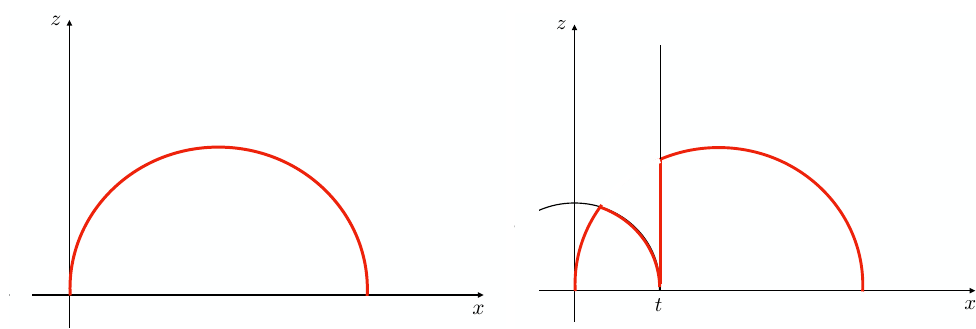
Figure 23 . A schematic drawing of connected geodesic (shaded red) on a time slice, without and with the existence of a boundary surface. This detour at the sharp corner of the boundary gives an increase of connected entanglement entropy. Note that the real geodesic does not exactly lie on a time slice.